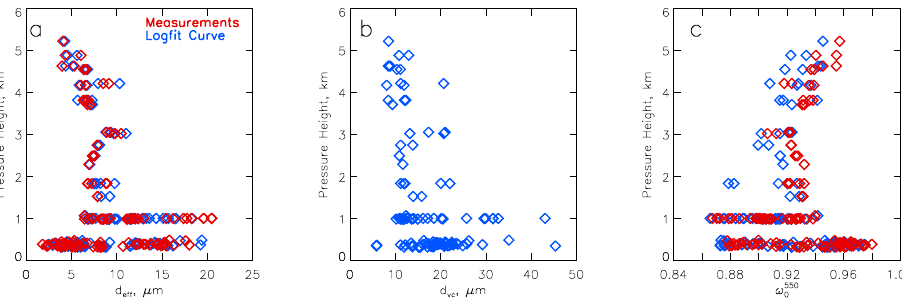
Fig. 10. Scatter plots showing (a) d eff , (b) d vc and (c) ω 550 against measurement altitude in terms of pressure height. All data points are 0 calculated from the full size distribution. Red points show calculations using the size distributions directly from the measurements, blue points show calculations using the logfit